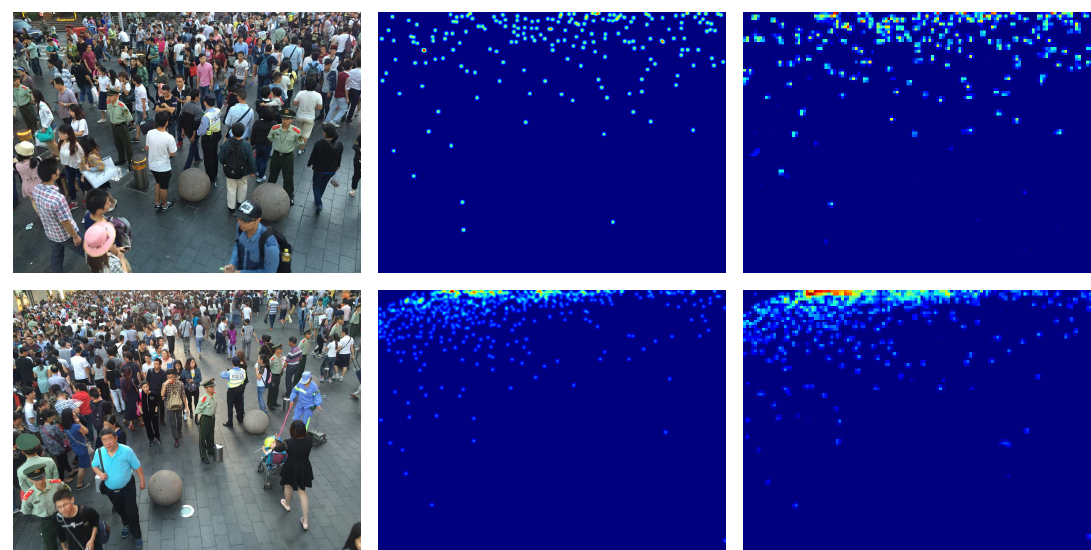
Figure 8. ShanghaiTech part B density map estimation examples. Left the crowd image, middle ground-truth density map, right estimated density map.